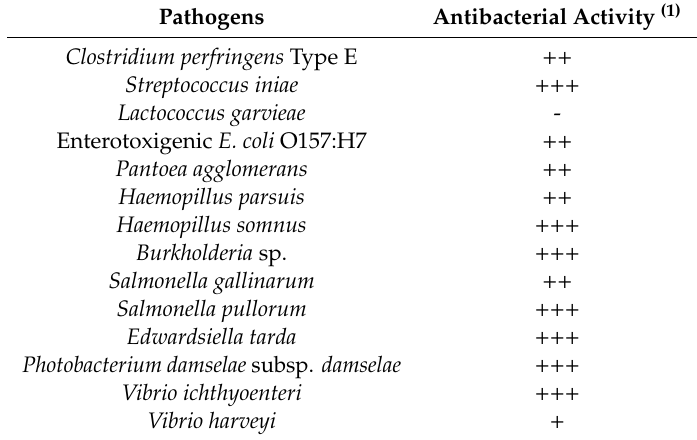
Table 1. Antibacterial activity of the fresh Chinese chive (CC) juice against